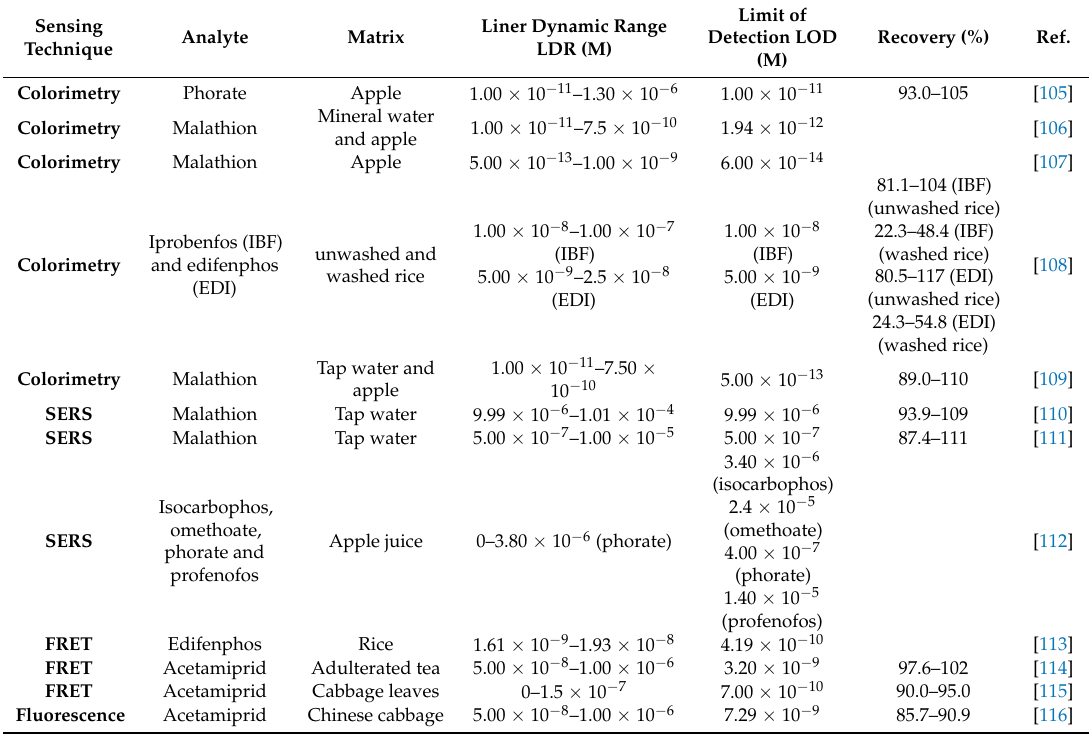
Table 4. Optical aptasensors for pesticides detection in food: main features and